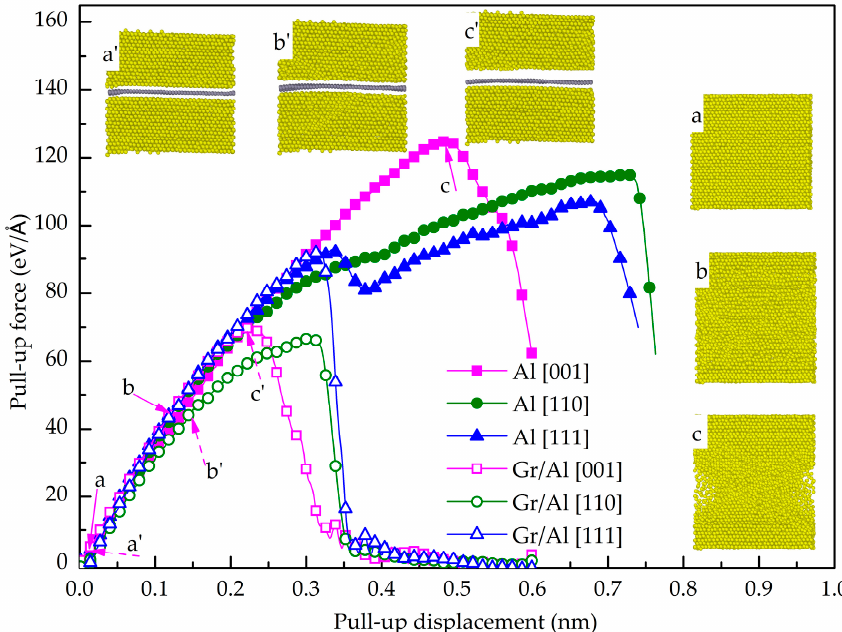
Figure 2. Pull-up force as a function displacement of the pure Al and GANC with three crystal orientations together with the structural deformations at different stages.